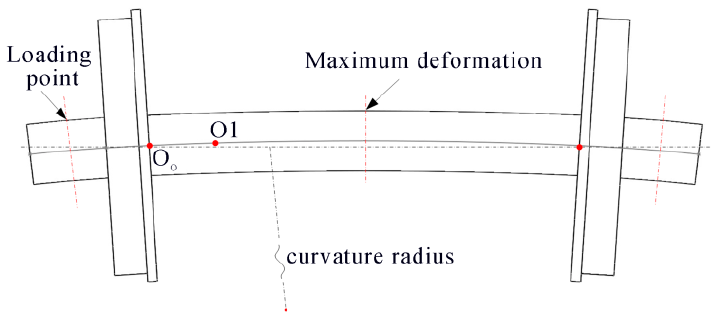
Figure 14. Deformation of the wheelset.